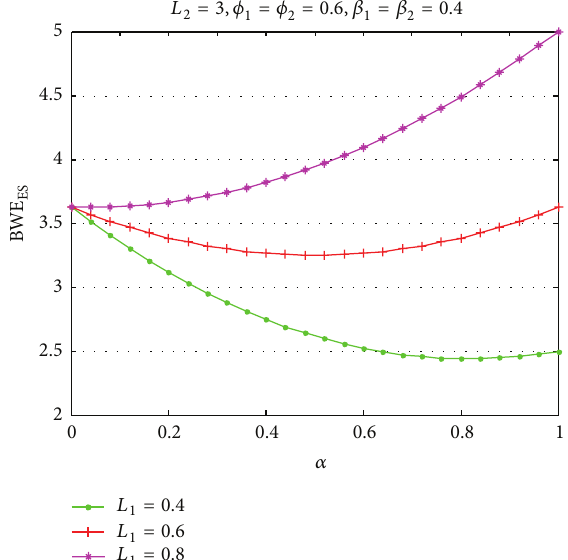
Figure 13: Impact of 𝛼 on bullwhip effect for different 𝐿 1 under the ES.